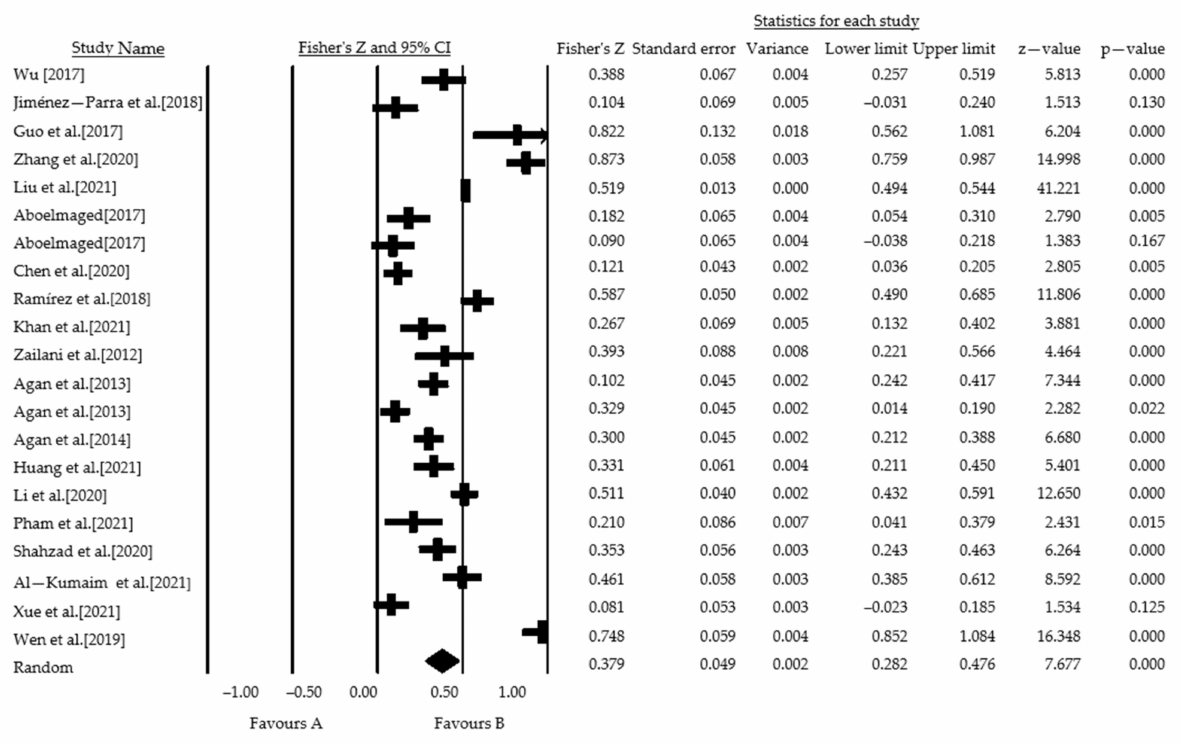
Figure 6. Total sample forest